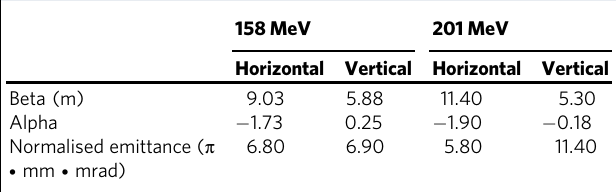
Table 3 Optimised Twiss parameters and normalised emittance of the electron beams.